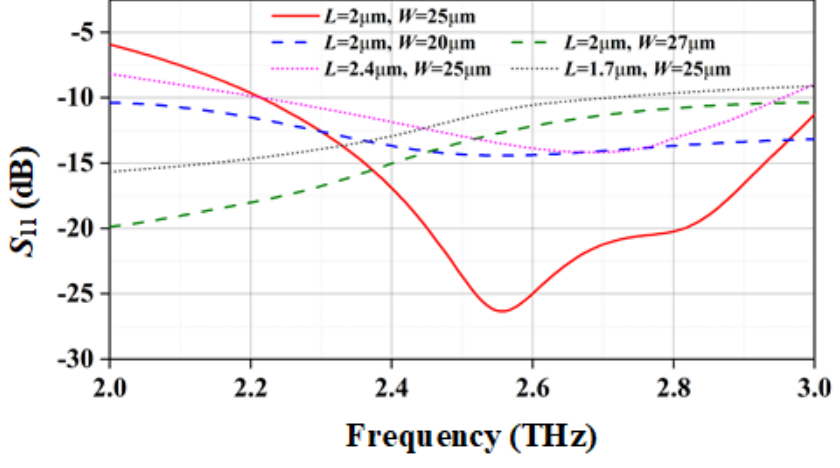
Figure 2. Simulated return loss of grating structure.